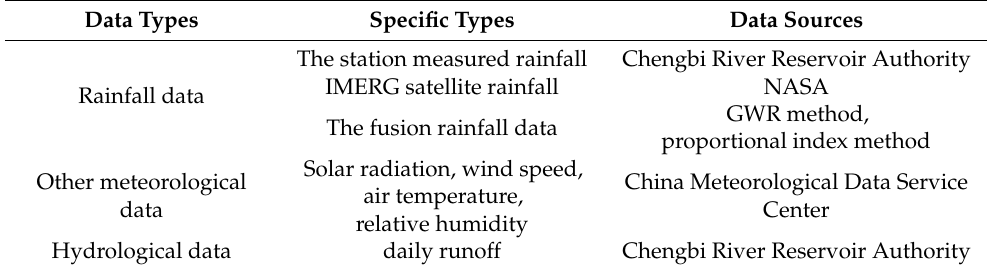
Table 2. Meteorological and hydrological data.